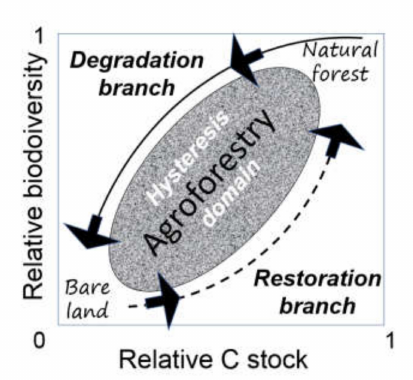
Figure 1. Relationship between carbon stocks and biodiversity across forest-derived land uses with agroforestry intermediate to degradation and restoration legs (modified from